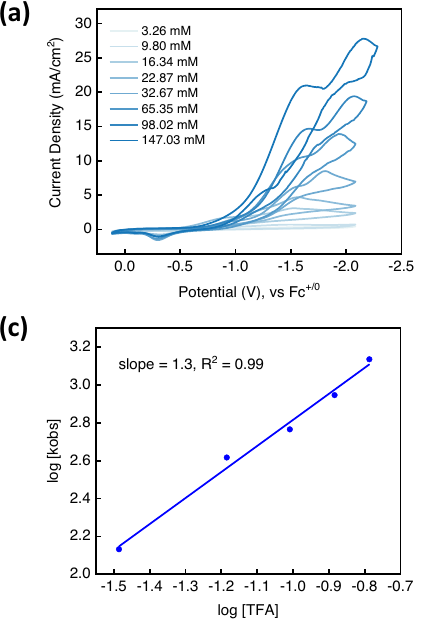
and have been obtained from an average of three trials of bulk electrolysis. c Double-log plot of k obs versus TFA concentration, with a slope of 1.3, indicating a fi rst-orderreactioninacid. d Plotof i cat vsconcentrationof 1 obtainedat32.67mM of TFA in a N 2 -saturated MeCN